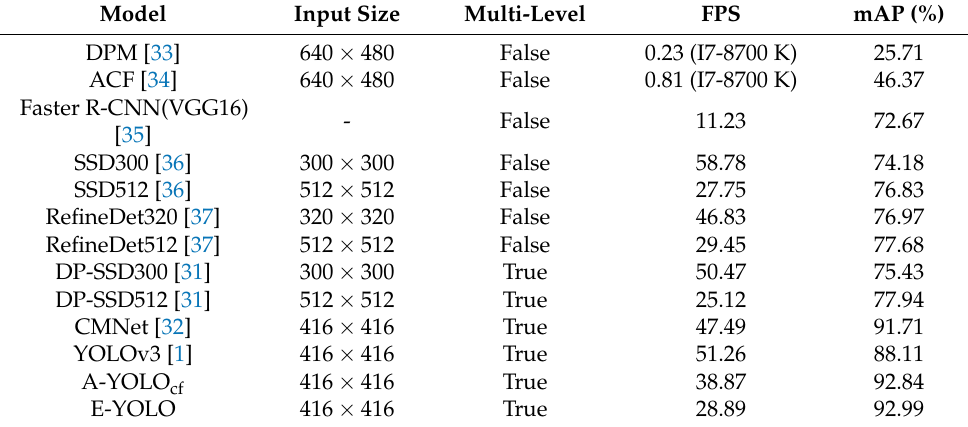
Table 2. Comparison of models on UA-DETRAC. We copied the released data on the website of UA-DETRAC and the results in several recent papers. To quantitate the improvement of our work, experiments on same 1080 Ti GPU with recent works are conducted. The caption of Multi-level means the usage of the combination of multi-level features inside each